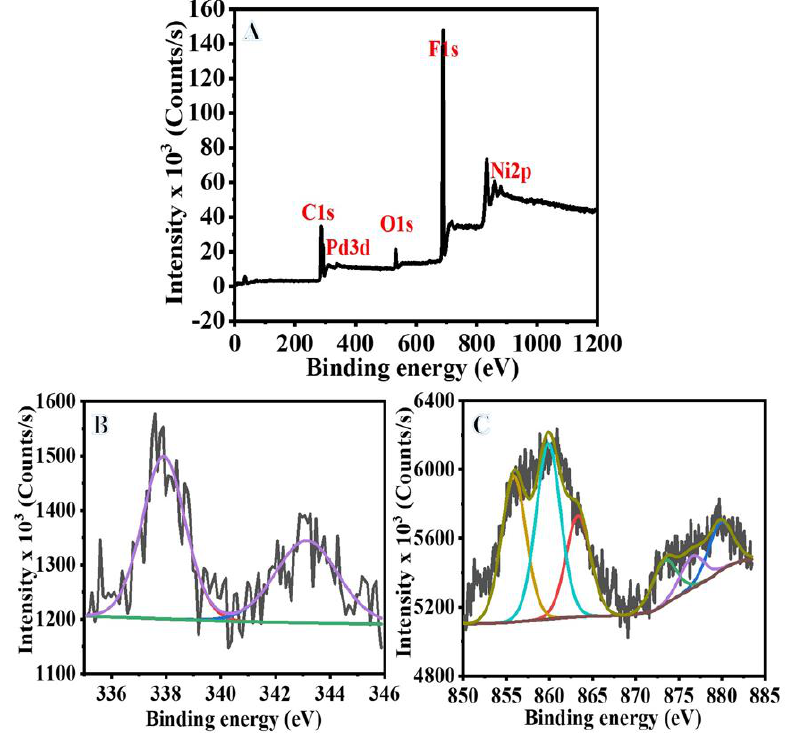
Figure 5. ( A ) Survey spectrum of Ni 75 Pd 25 @PVDF-HFP NFs membrane, ( B ) Pd3d, and ( C ) Ni2p.